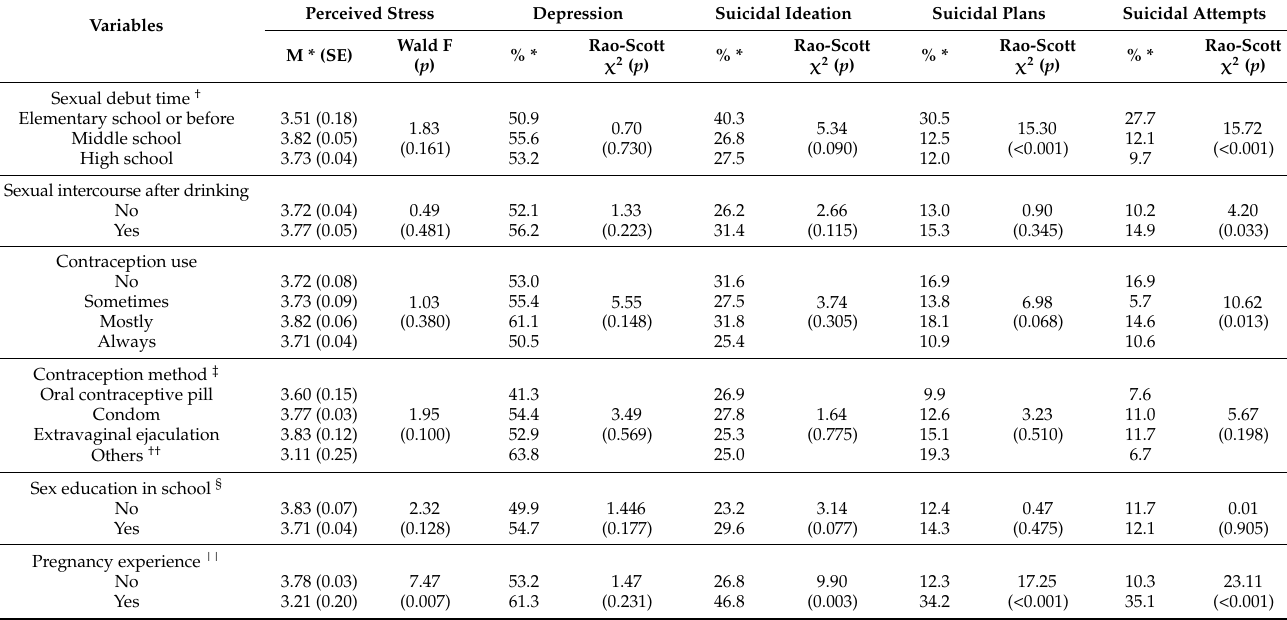
Table 3. Differences in mental health according to sexual behavior in girls ( n =